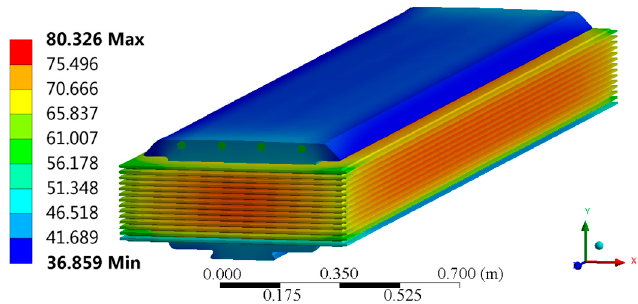
Figure 4. Temperature field of magnetic pole under normal excitation winding.